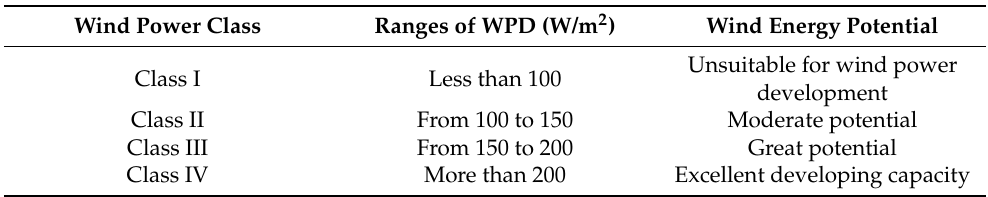
Table 4. WPD Classification. Wind Power